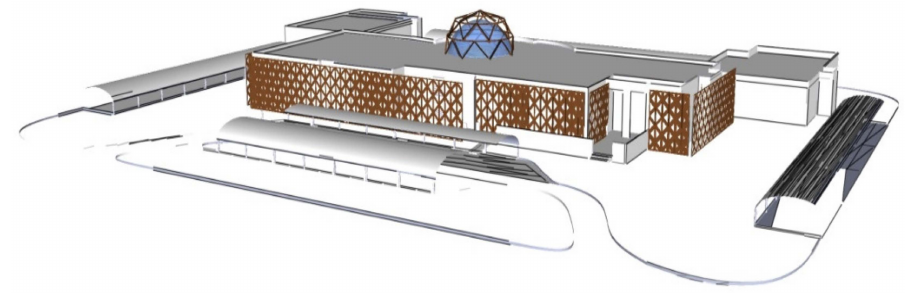
Figure 12. 3D of the retrofitted model.